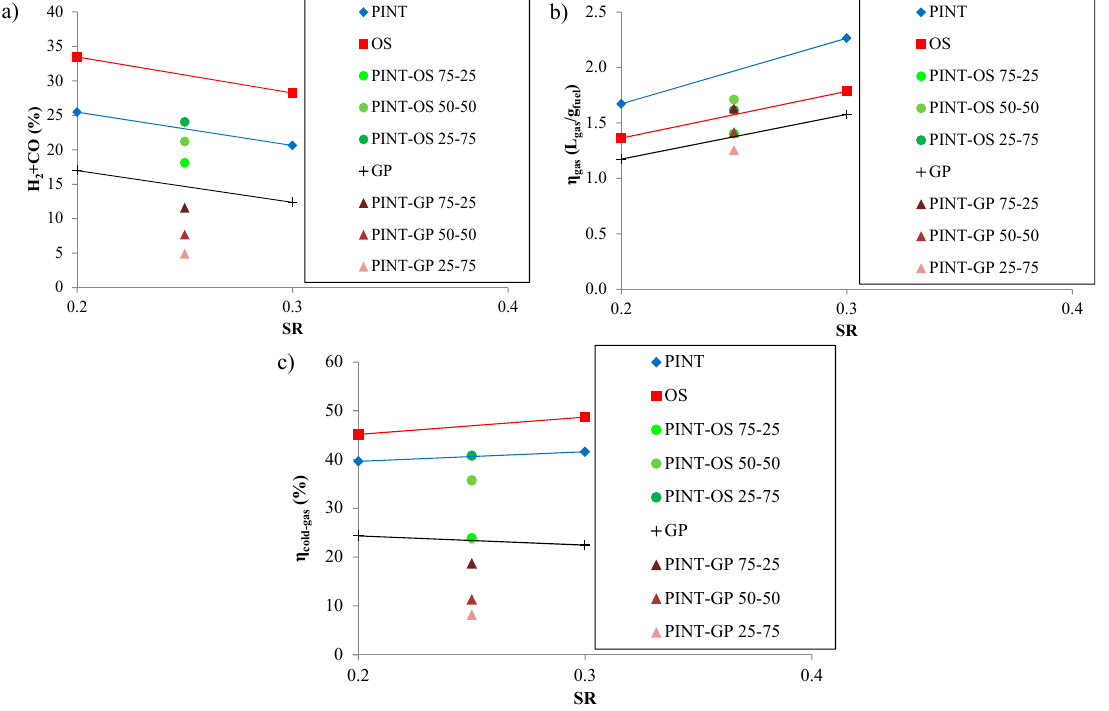
Figure 4. Results of the syngas composition ( a ) (CO + H 2 ), ( b ) gas yield and ( c ) cold-gas efficiency of the biomass mixtures.